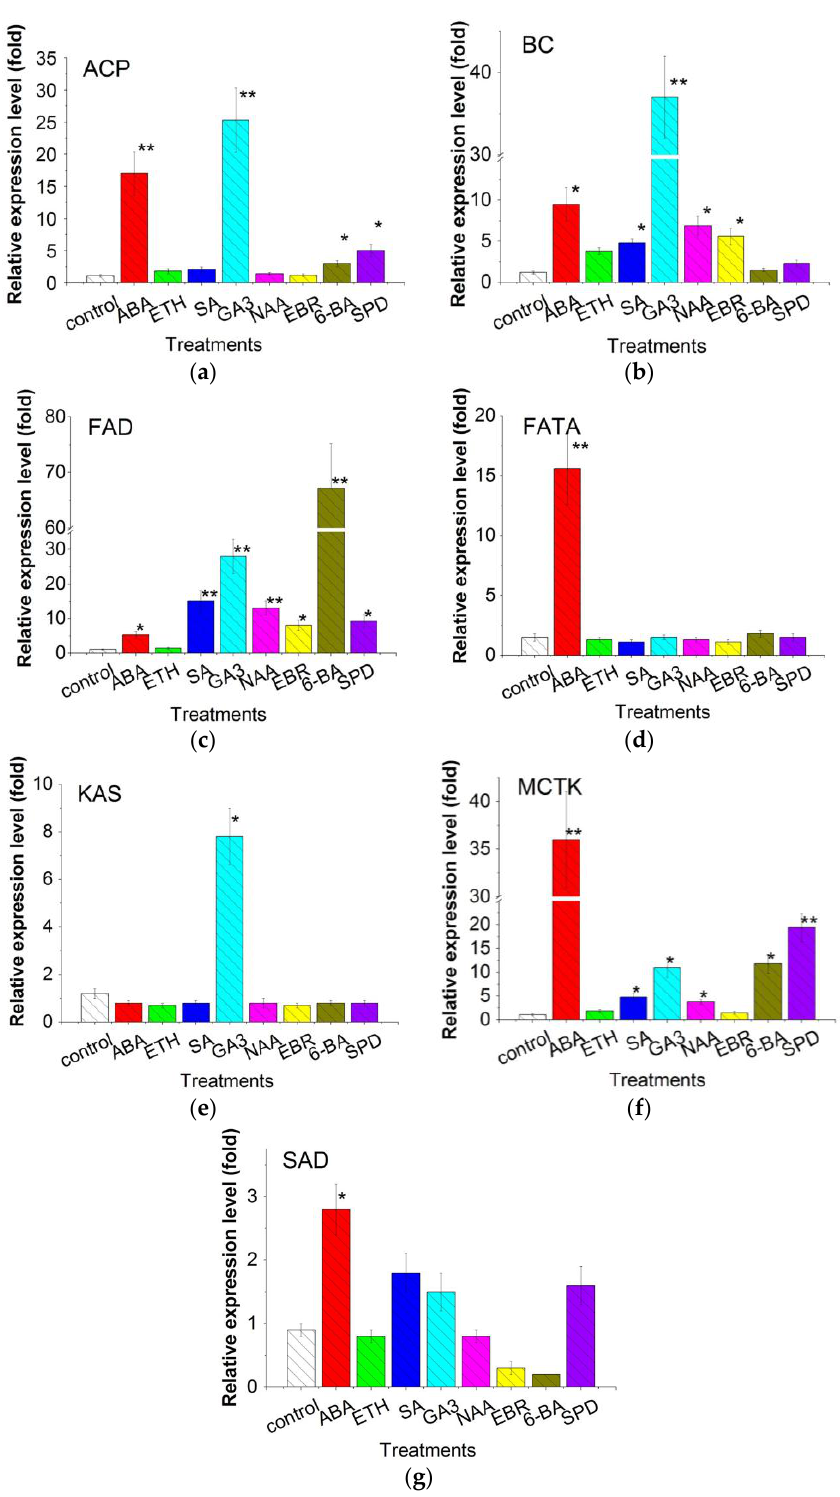
Figure 7. Gene expression detected by real-time qPCR at different concentrations of plant growth regulators: ( a ) relative expression of ACP ; ( b ) relative expression of BC ; ( c ) relative expression of FAD ; ( d ) relative expression of FATA ; ( e ) relative expression of KAS ; ( f ) relative expression of MCTK ; ( g ) relative expression of SAD .